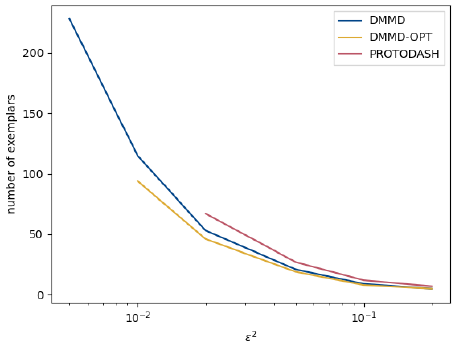
Figure 6. Coreset size required to obtain an (cid:101) -MMD dependent coreset on the 12 yearbook datasets, for three algorithms. Algorithms ran for a maximum of one hour; PROTODASH failed to complete coresets for (cid:101) 2 = 0.01 and (cid:101) 2 = 0.005. DMMD - OPT failed to complete a coreset for (cid:101) 2 =